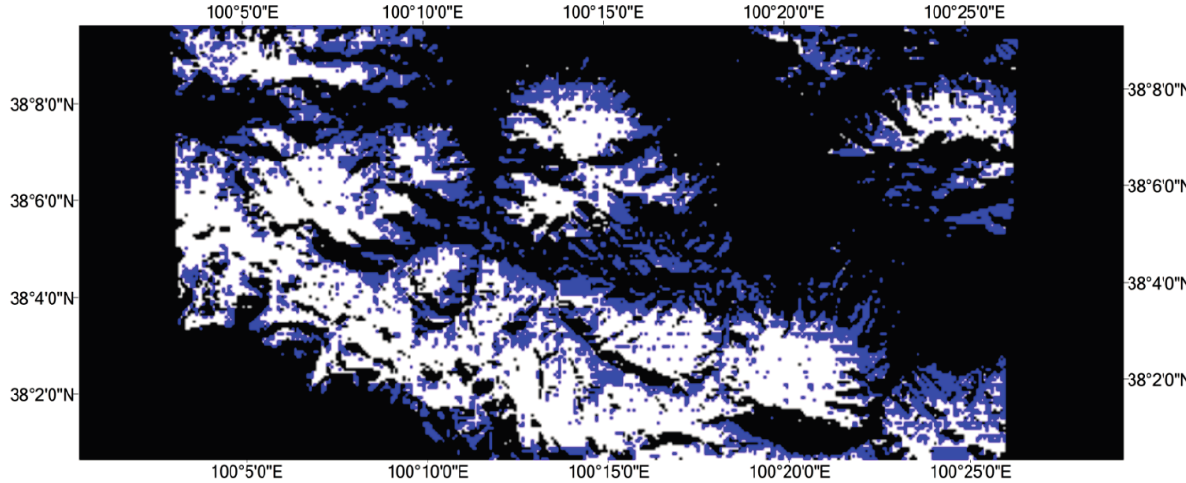
Figure 11. Comparison between MODIS snow cover fraction and the real snow cover fraction retrieved from high-resolution satellite images such as TM, CHRIS and EO-1 images. The radius of a blue circle represents the overall accuracy (OA) of a downscaled snow map based on high-resolution satellite images, and the radius of a red circle represents that of a downscaled map based on MODIS SCF products. For clarity, four annotations are presented in the figure: OAs of downscaled snow maps based on TM and CHRIS data are compared with those of MODIS products.